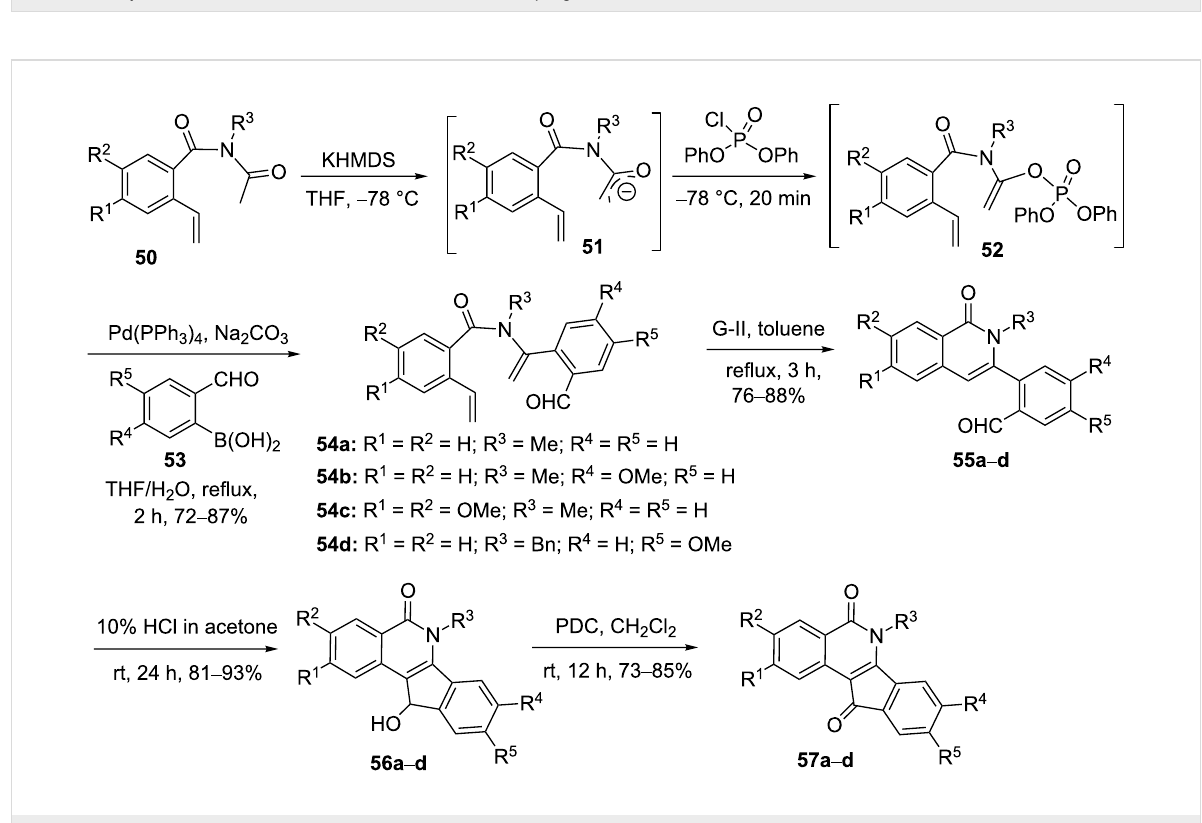
Scheme 7: Synthesis of truxene derivatives via RCM and SM coupling.